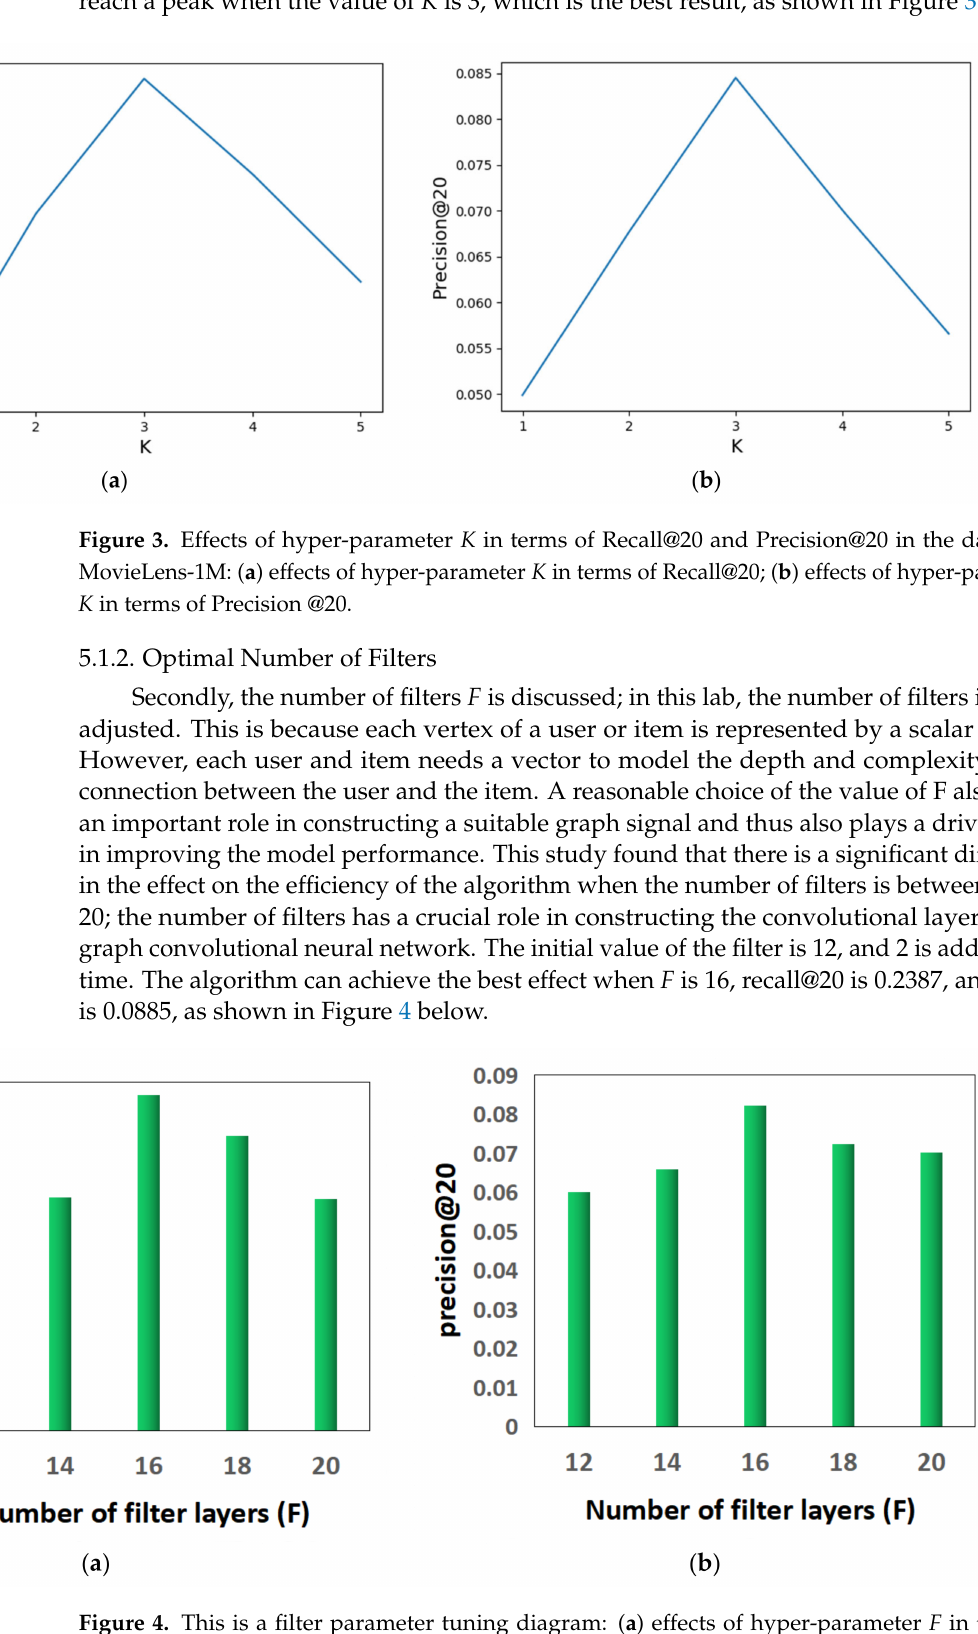
Figure 4. This is a filter parameter tuning diagram: ( a ) effects of hyper-parameter F in terms of Recall@20; ( b ) effects of hyper-parameter F in terms of